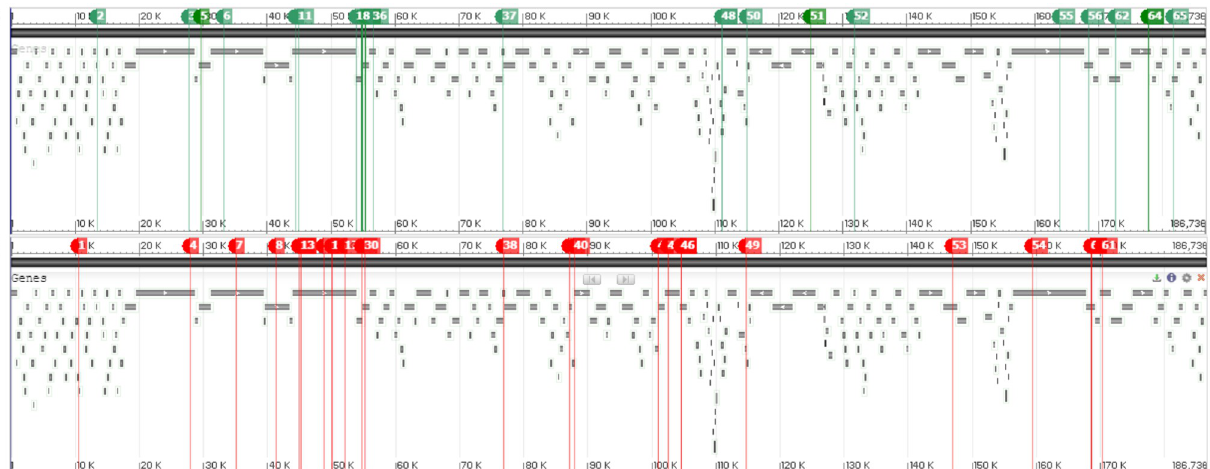
PLOS ONE | https://doi.org/10.1371/journal.pone.0281537 February 9,